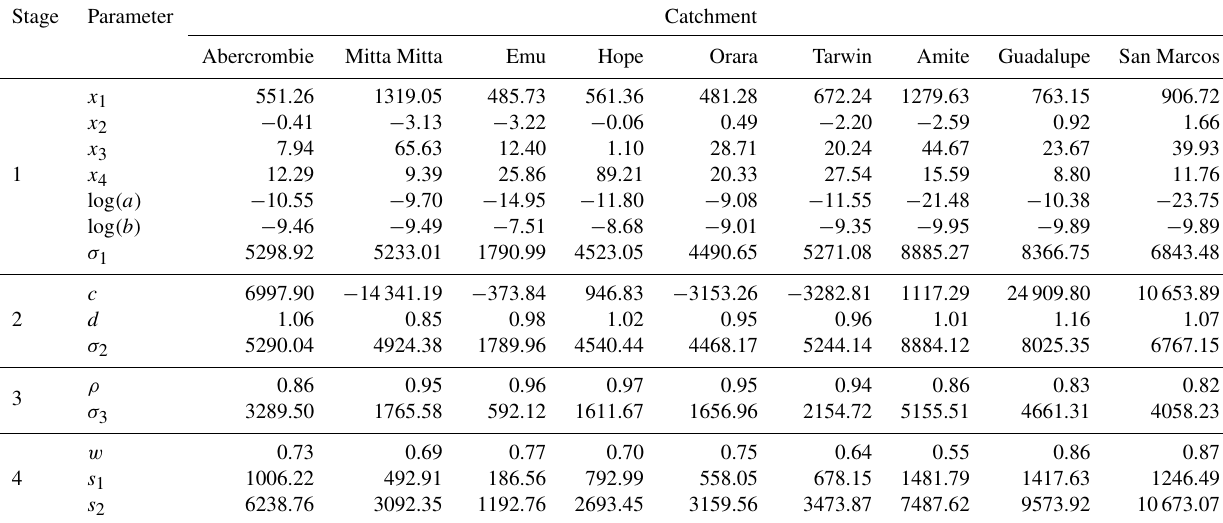
Table 4. The calibrated error model parameters for the selected catchments. Stage